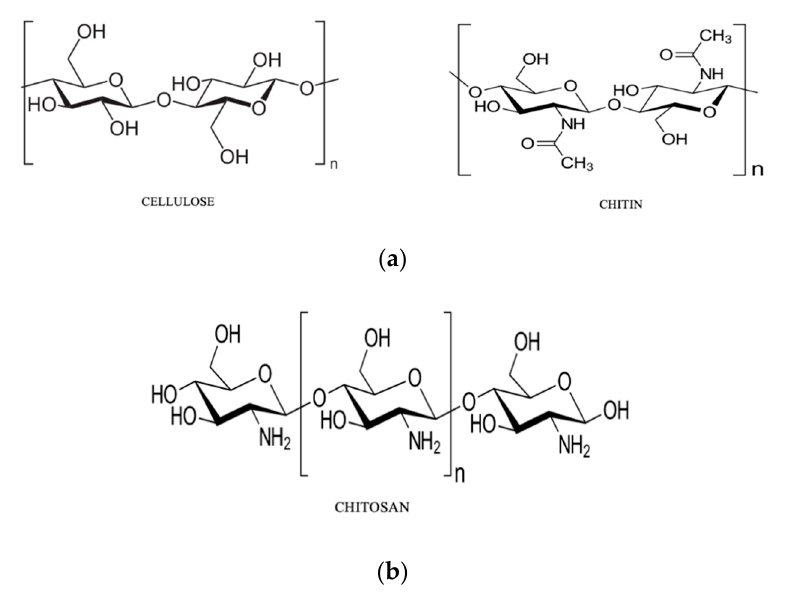
Figure 1. ( a ) Difference between cellulose and chitin polymers. ( b ) Structure of chitosan polymer. Figure 1. ( a ) Di ff erence between cellulose and chitin polymers. ( b ) Structure of chitosan